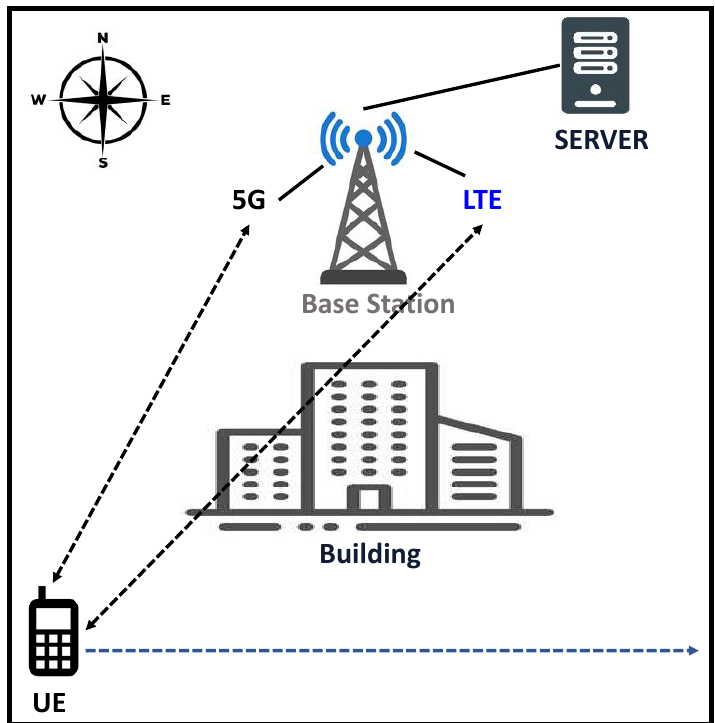
Figure 2. An illustration of the considered simulation scenario.